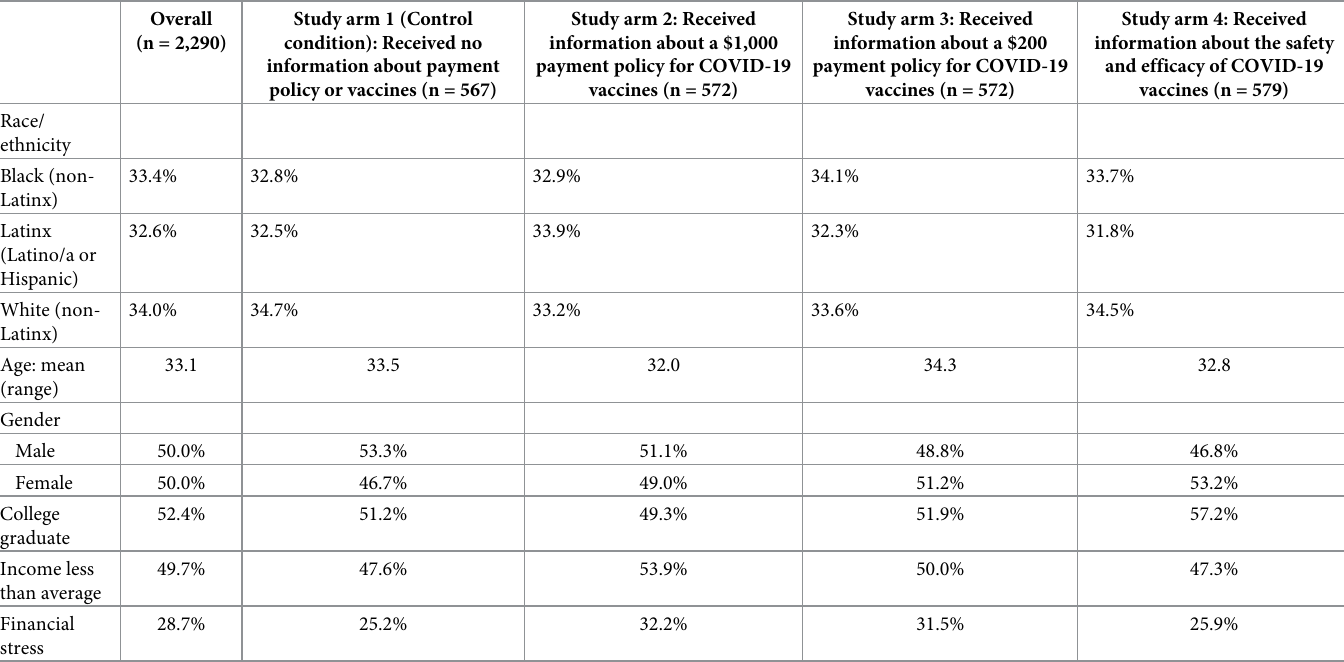
Table 1. Characteristics of the study sample, overall and by study